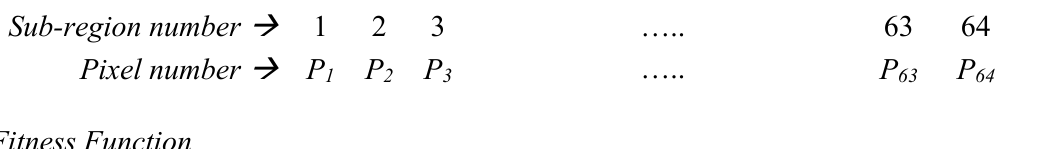
Figure 7. Individual representation of sensor